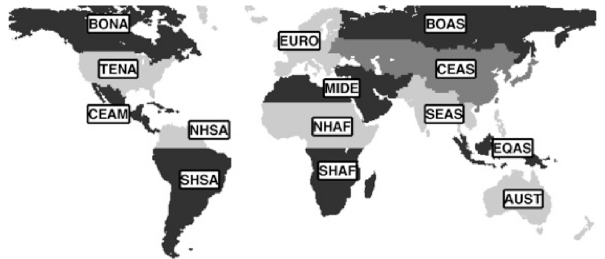
Figure 7. Regions used to aggregate observation- and model- derived fire activity data in Fig.